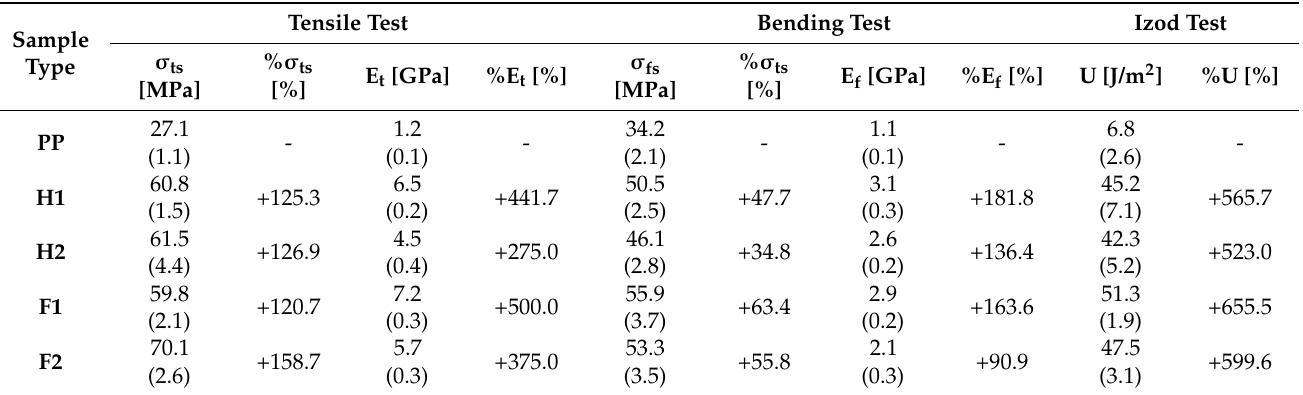
Table 3. Main tensile, flexural and impact properties of samples, mean values and standard deviations (between brackets). σ ts : tensile strength; % σ ts : percentage increase of σ ts than PP; E t : tensile